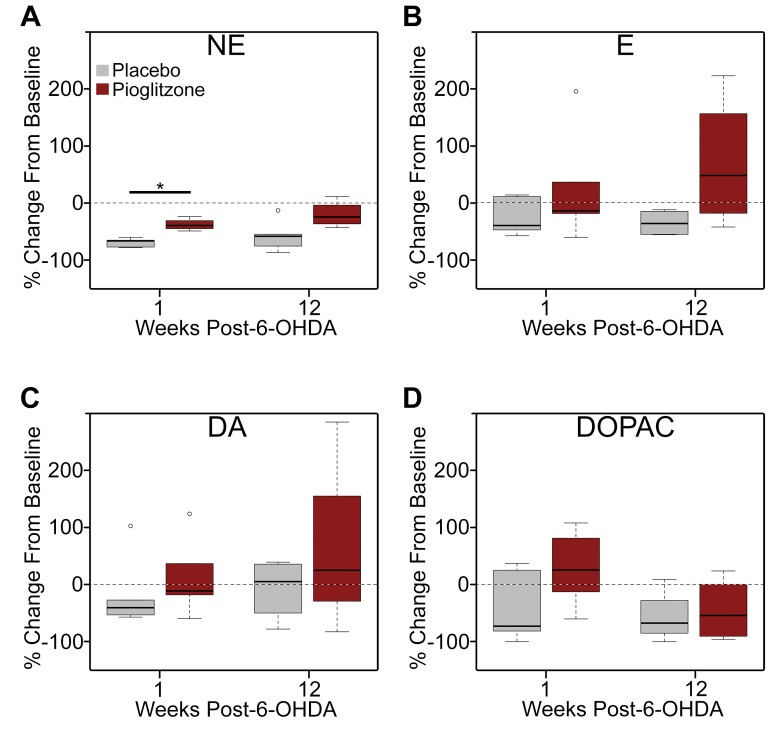
6-OHDA-induced loss of circulating norepinephrine 1 week post-neurotoxin was attenuated by PPARγ activation.(A-D) Box and whisker plots illustrating percent change from baseline to 1 and 12 weeks post-neurotoxin for plasma (A) norepinephrine (NE), (B) epinephrine (E), (C) dopamine (DA), (D) and 3,4 dihydroxyphenylacetic acid (DOPAC). *, p < 0.016. Unfilled circles indicate values that are more than 1.5x the interquartile range above the 75th percentile. 6-OHDA, 6-hydroxydopamine; PPARγ, peroxisome proliferator-activated receptor gamma.